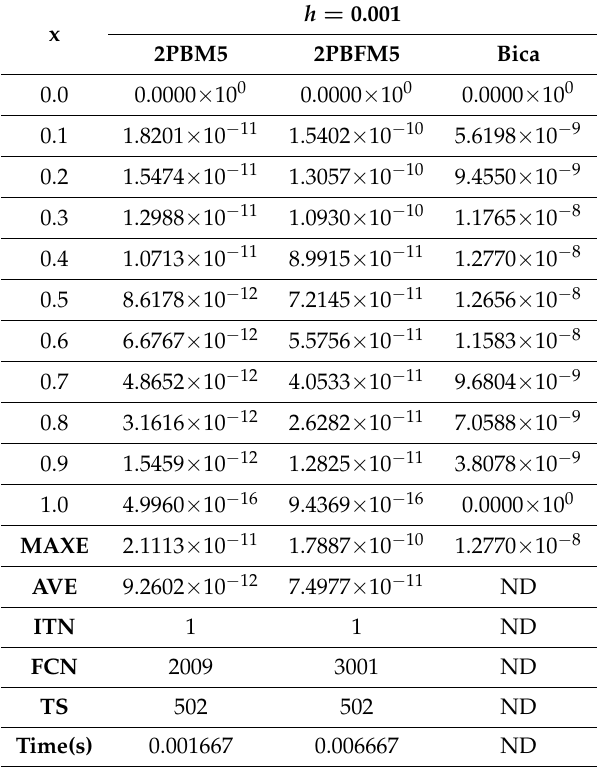
Table 4. The comparison results for Problem 2 at h = 0.001.